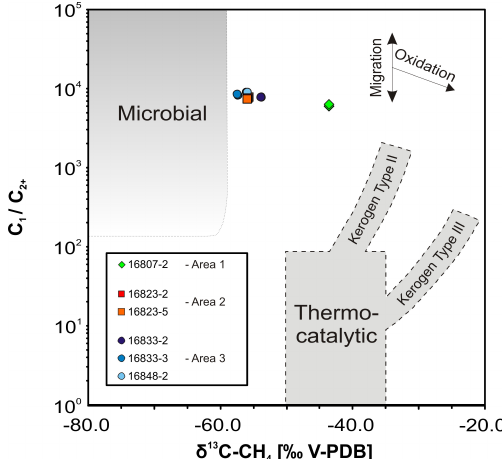
Figure 10. Molecular (C 1 /C 2 + ) vs. stable C isotopic composition of methane ( δ 13 C-CH 4 ) sampled in Areas 1–3. Classification ac- cording to the “Bernard diagram” modified after Whiticar (1990). Gas samples studied herein are plotted close to the empirical field of microbial methane except for those from Area